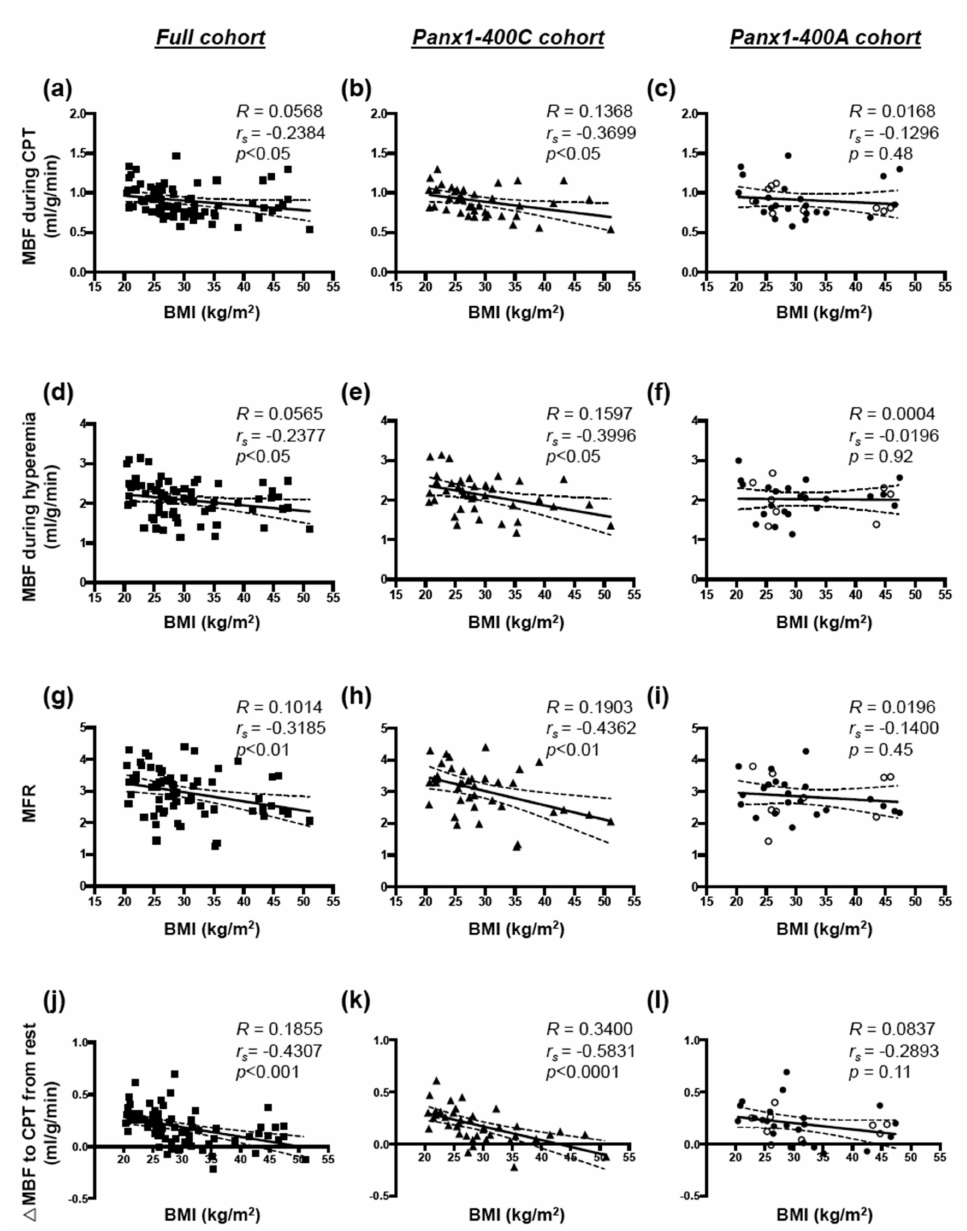
Figure 2. BMI, hemodynamic parameters and Panx1-400A > C SNP. Spearman correlations between body mass index (BMI) and myocardial blood flow (MBF) during cold pressor test (CTP) ( a – c ), MBF during hyperemia ( d – f ), myocardial flow reserve (MFR) ( g – i ) and endothelial function ( ∆ MBF to CPT from rest, j – l ) in the full cohort (( a , d , g,j ) n = 72), the Panx1-400C cohort ( b , e , h,k ) n = 40) and the Panx1-400A cohort ( c , f , i,l ) n = 32). AA genotype: open circles; AC genotype: closed circles. MBF at rest, MBF during hyperemia and MFR were not di ff erent between non-obese (BMI < 30 kg / m 2 ) and obese (BMI ≥ 30 kg / m 2 ) subjects in the three cohorts and were not a ff ected by the Panx1-400A > C SNP (Table 3). During CPT, MBF was reduced in obese subjects in comparison to non-obese individuals in the full cohort (Table 3). A similar trend was observed in the Panx1-400C cohort but not in the Panx1-400A cohort (Table 3). Mean endothelial function was reduced in obese individuals in comparison to non-obese subjects in all three cohorts (Table